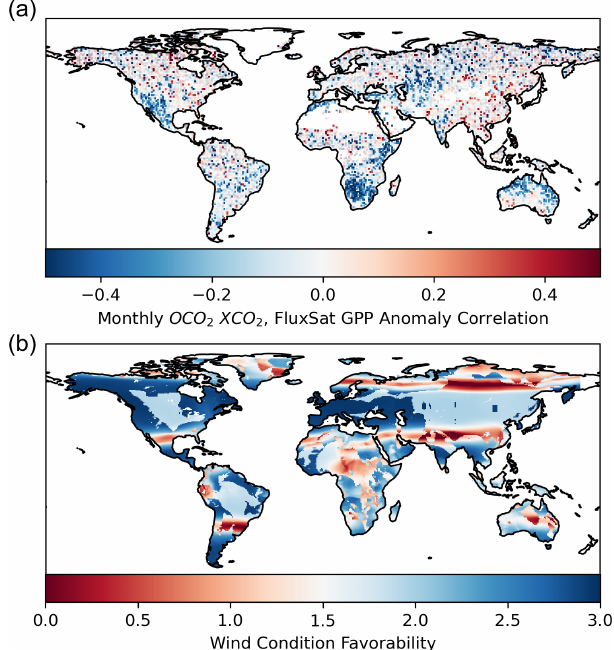
Figure 1. (a) Observed coupling between terrestrial biosphere surface CO 2 flux anomalies and atmospheric CO 2 concentration anomalies. Monthly anomaly correlation between observed column CO 2 (XCO 2 ) from OCO-2 and observation-based FluxSat GPP (de- rived primarily from MODIS). Pixels that are not statistically sig- nificant ( p< 0 . 05) are transparent. (b) Wind condition favorability index for application of simple mass-balance estimation approaches based on mean monthly lower troposphere (surface up to approxi- mately 700mbar) conditions from MERRA2. The index is high if the wind direction monthly temporal variability is low, wind direc- tion spatial variability is low, and wind originates from water bod- ies. See Fig. S2 for mapped components contributing to the wind condition favorability